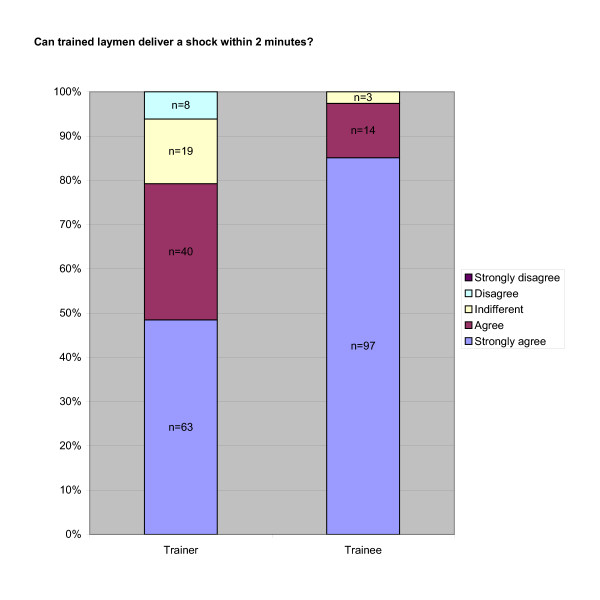
Can trained laymen deliver a shock within 2 minutes?. The trainer (student) rated if the trainee (patient) would be able to deliver a shock within 2 minutes in case of a cardiac arrest. The trainee (patient) rated how confident he felt about delivering a shock within 2 minutes in case of a cardiac arrest. ("The participant would deliver a shock within 2 minutes in case of an emergency."/"I would be able to deliver a shock in case of an emergency.").